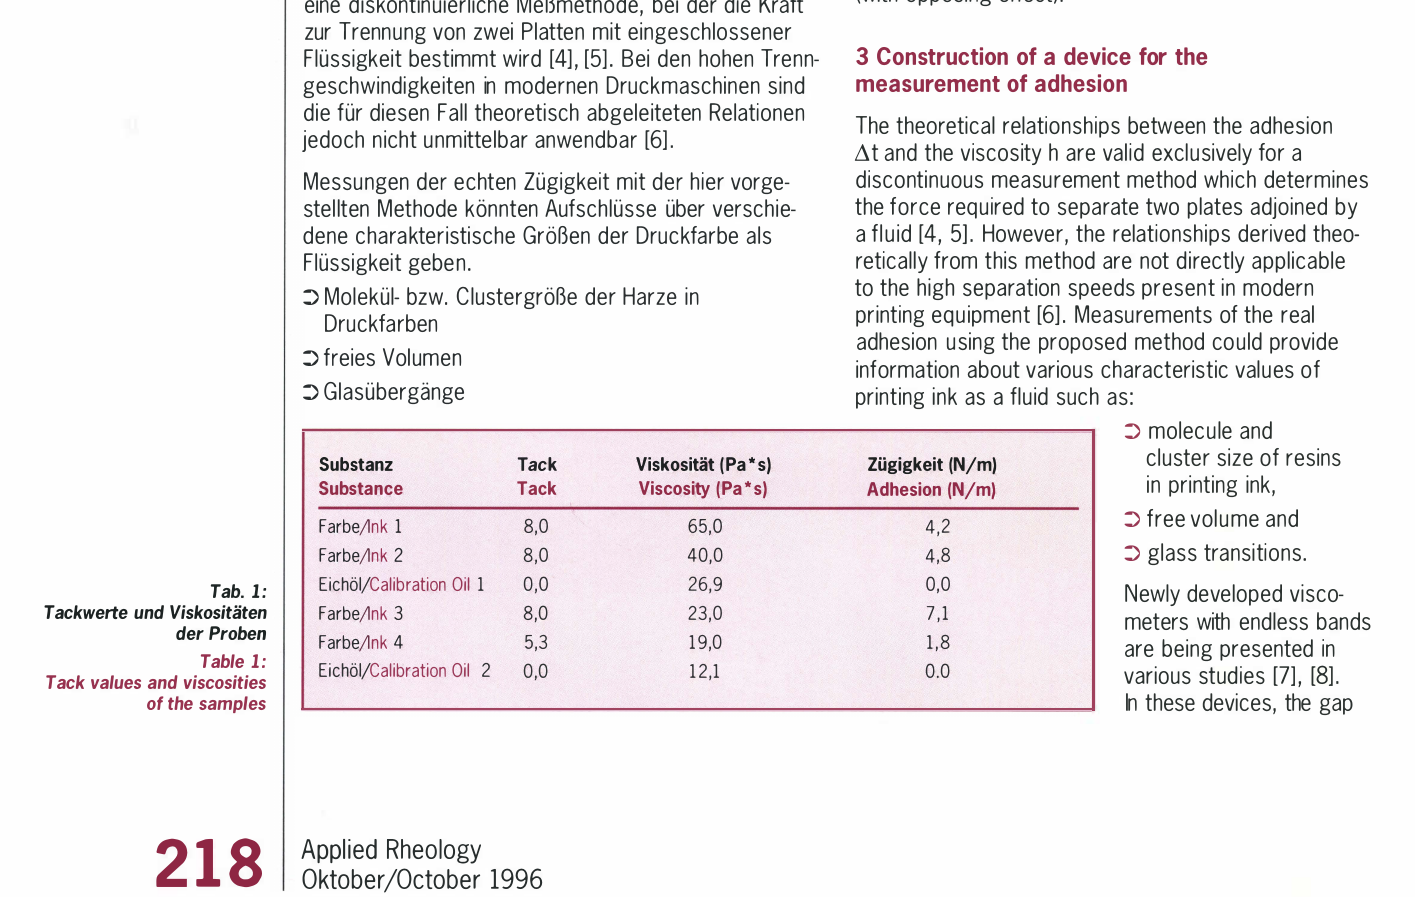
Tab. 1: Tackwerte und Viskositiiten der Proben Table 1: Tack values and viscosities of the samples